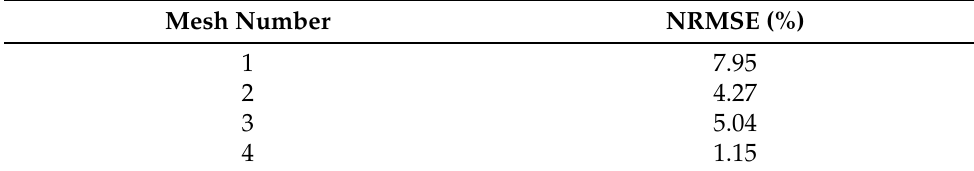
Table 4. NRMSE values for each mesh discretization